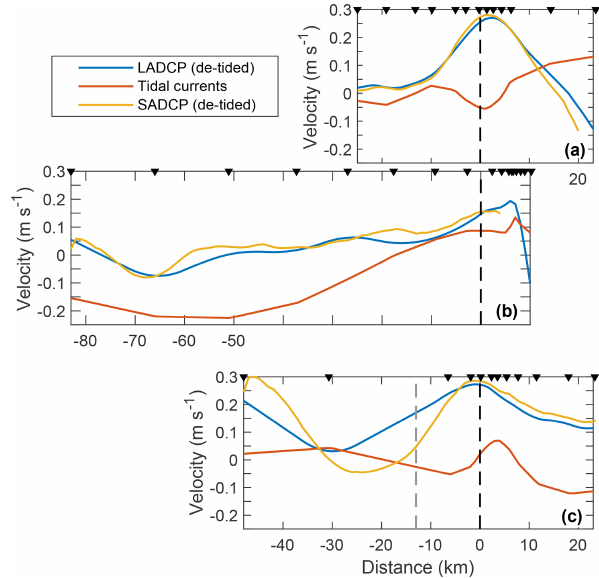
Figure 5. De-tided LADCP (blue) and SADCP velocities (yellow) vertically averaged between 50 and 500m depth and tidal currents (red) for sections A (a) , B (b) and C (c) . The dashed gray line at − 11km in (c) shows the outer bound of the stream tube 1 in Section C, based on SADCP measurements. Other details are as in Fig.